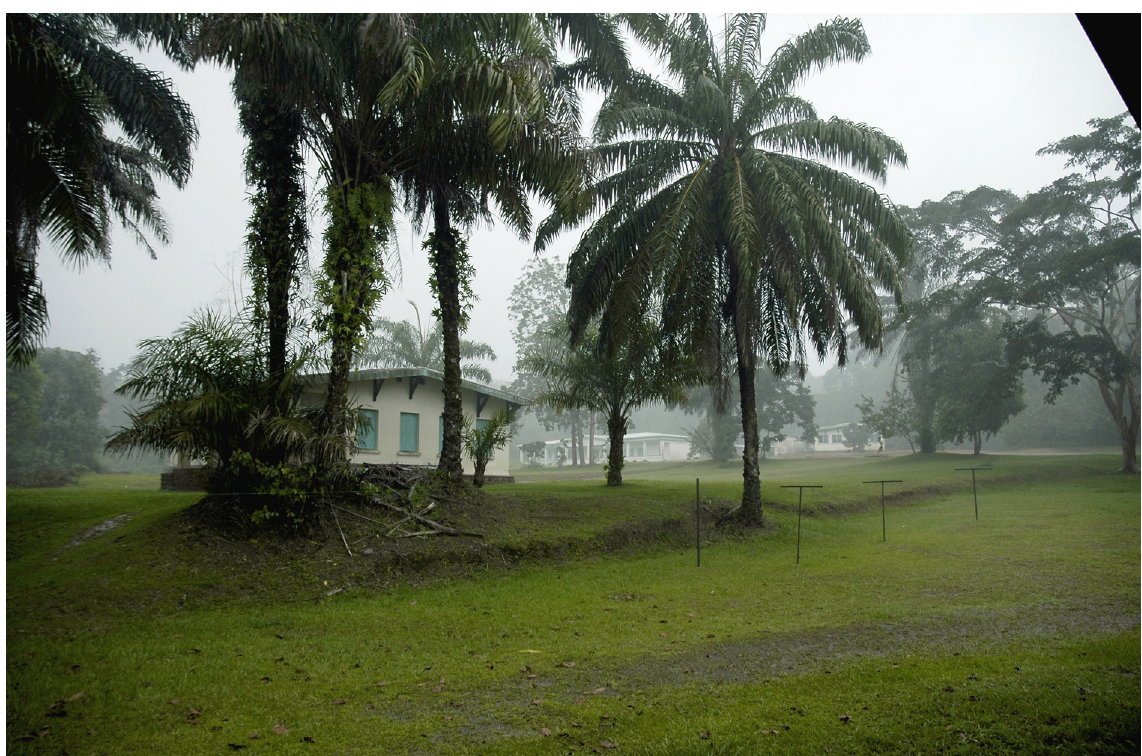
Fig. 2. The Ipassa research station in Ivindo National